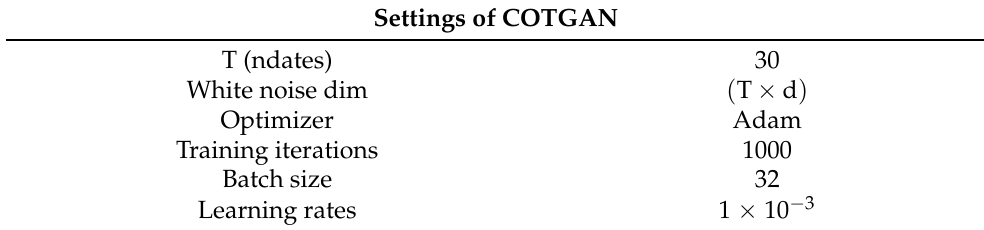
Table A2. Generator neural network hyper-parameters for COTGAN.